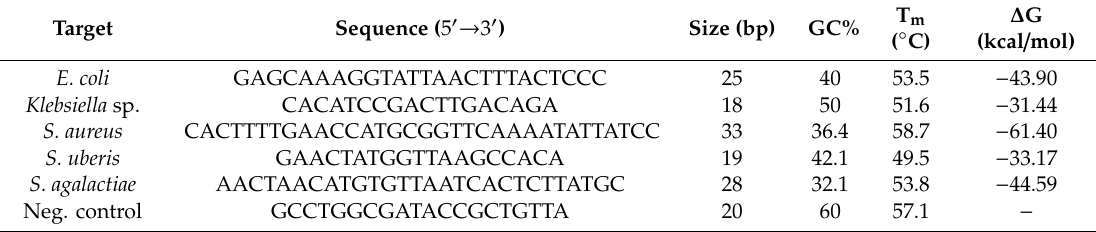
Table2. Sequence, size, GCcontent, meltingtemperature(T m )andchangeinfreeenergyofhybridization ( ∆ G) of the oligonucleotide probes specifically designed to target each bacteria ( E. coli , Klebsiella sp., S. aureus , S. uberis, and S. agalactiae ) and the negative control. The melting temperature and Gibbs energy were calculated by the nearest-neighbor